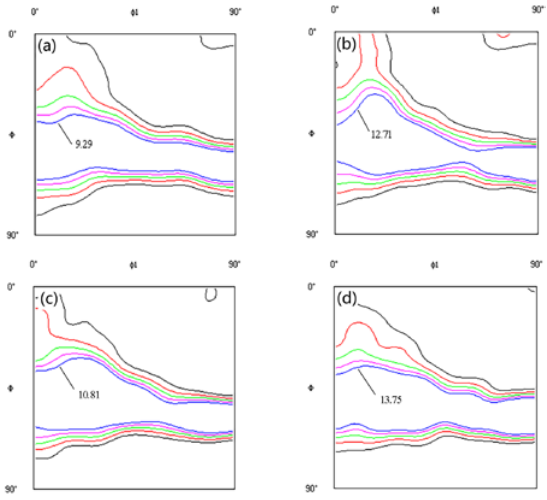
Figure 5. Orientation distribution function(ODF) sections ( ϕ 2 = 45 ◦ ) at di ff erent annealing temperatures. ( a ) 710 ◦ C, ( b ) 730 ◦ C, ( c ) 760 ◦ C and ( d ) 780 ◦ C.